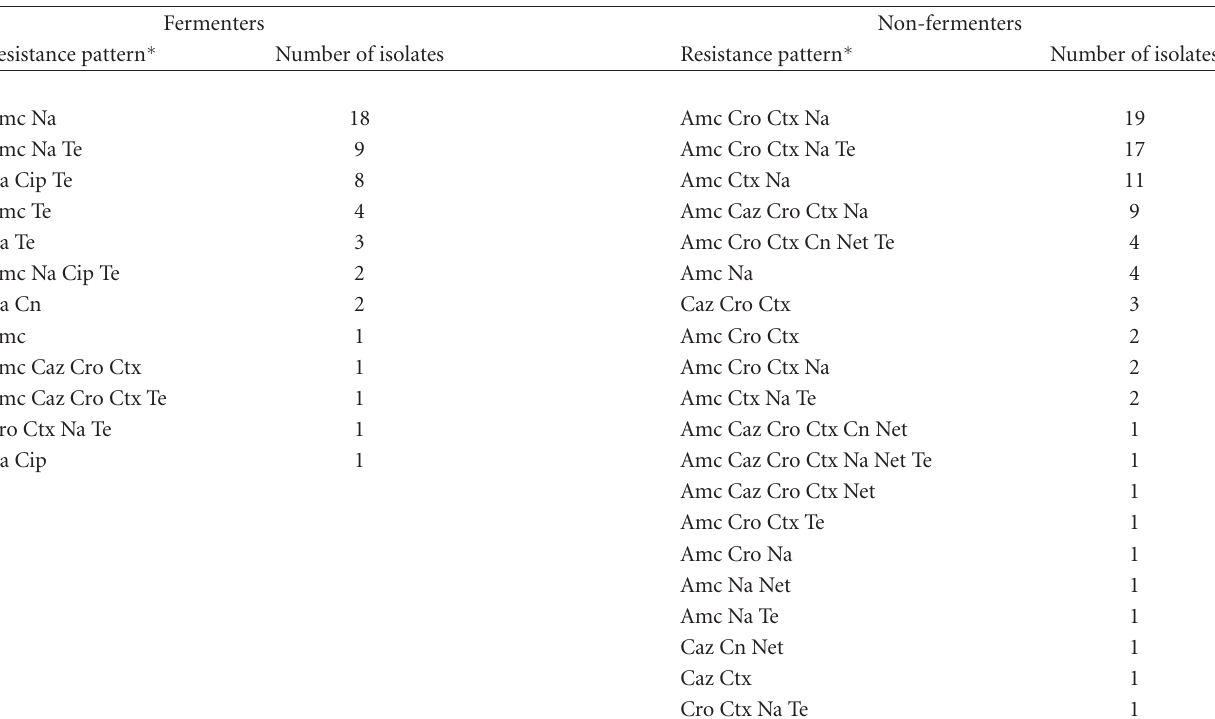
Table 2: Resistance patterns to antibacterial drugs tested in fermenters and nonfermenters. Fermenters